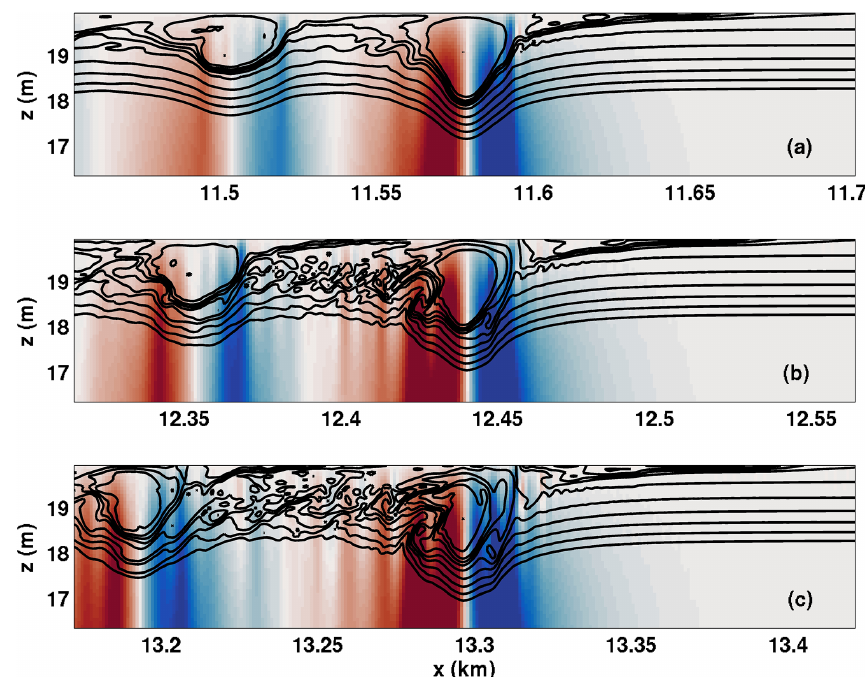
Figure 9. Detail of vertical velocity (shaded and saturated at ± 0 . 01ms − 1 ) and density fields in the core region for wave trains propagating with the shear current critical layer case CL 1. Ten density isolines with − 5 × 10 − 4 < ρ < − 4 × 10 − 4 shown in black. (a) t = 7200s, (b) t = 9000s, and (c) t = 10800s.